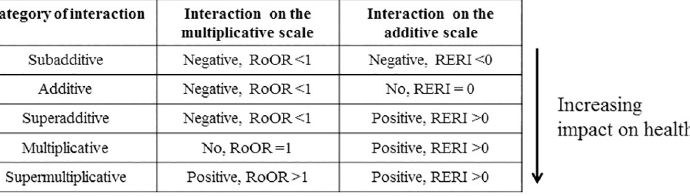
Fig 3. Interaction continuum and 5 categories of interaction on additive and multiplicative scales considered in this study. RoOR, ratio of odds ratios; RERI, relative excess risk due to interaction.